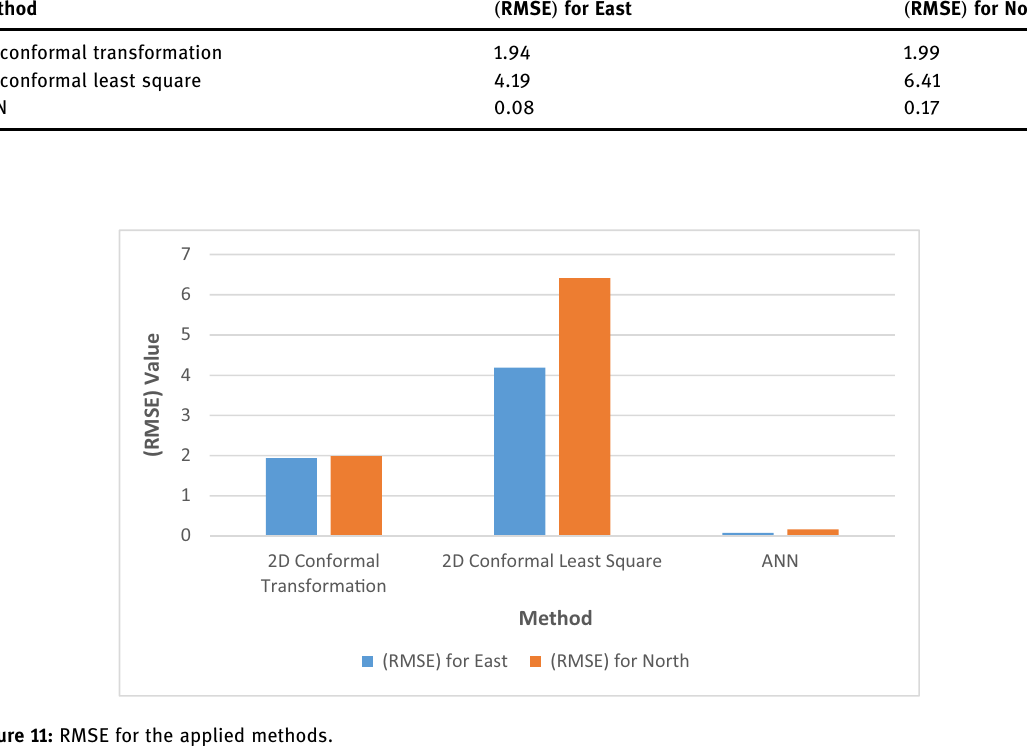
Table 1: Root mean square error for the applied methods Method